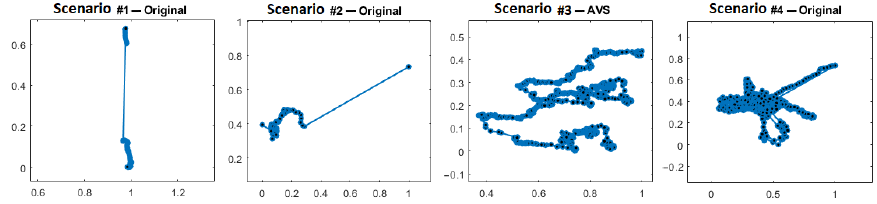
Figure 6. The sample of camera motion paths for the four scenarios in Experiment